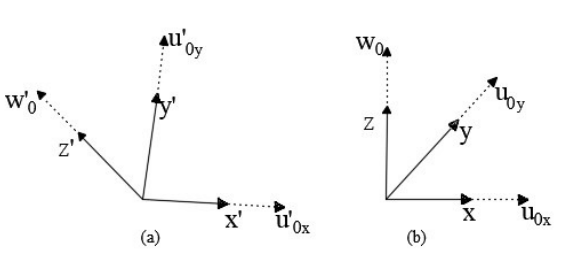
Figure 3: Positive directions for Local and global translation dis- placements